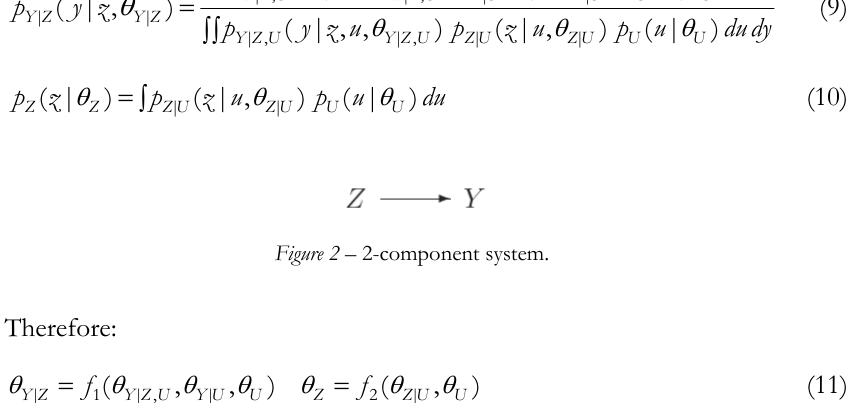
Figure 2 – 2-component